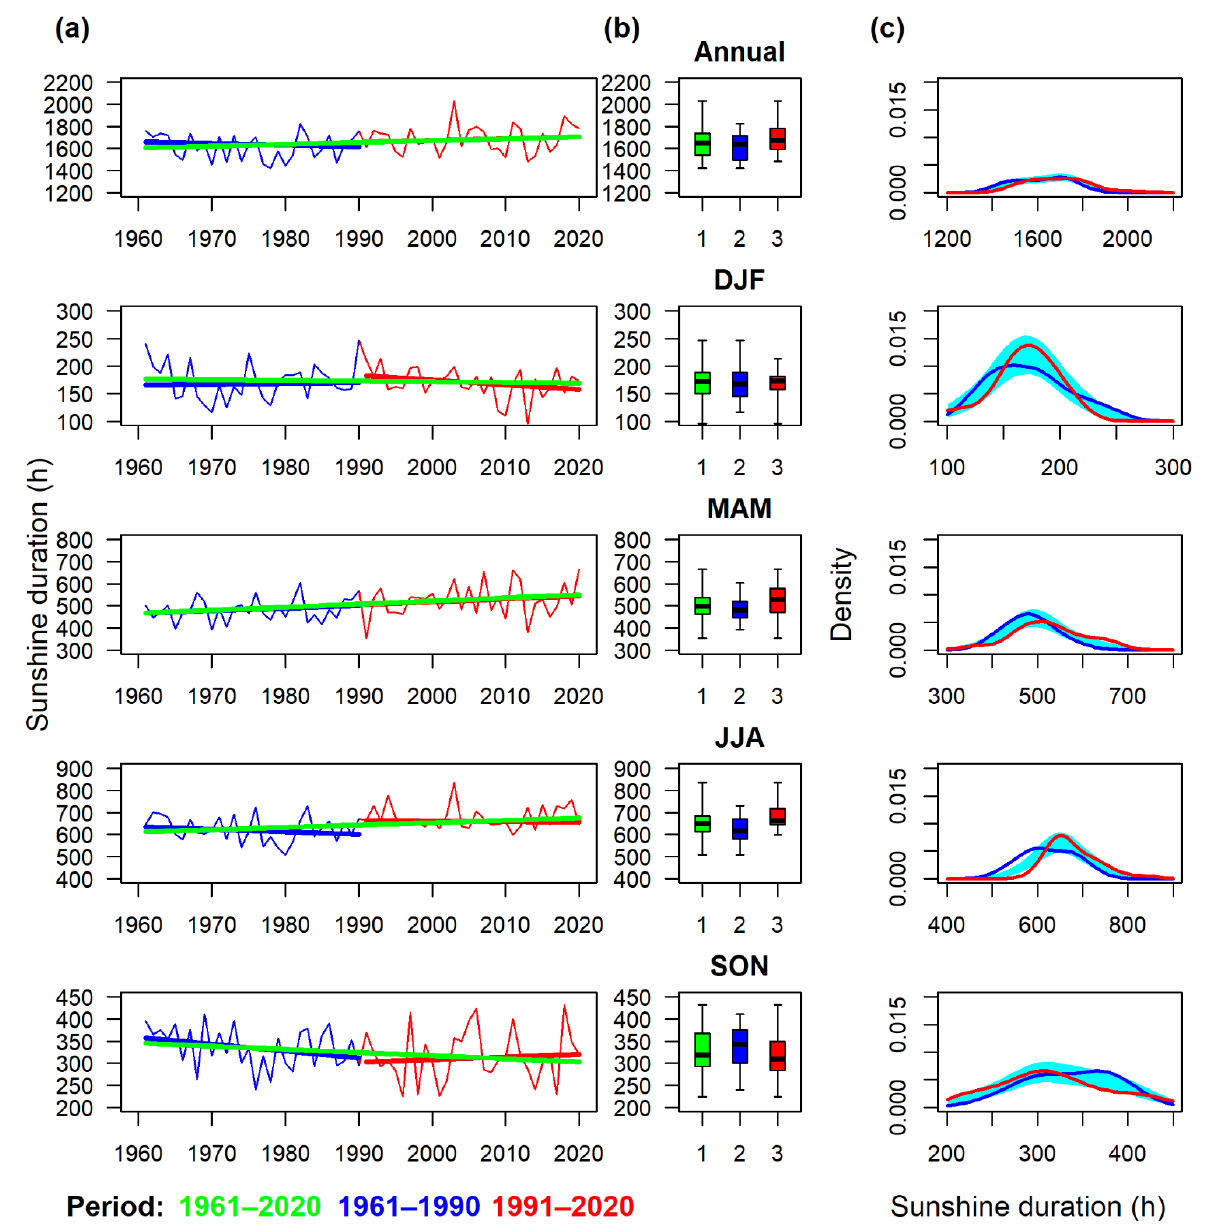
Figure 5. Mean annual and seasonal series of sunshine duration for the territory of the Czech Republic in the 1961–2020 period: ( a ) fluctuations with linear trends in the entire period, 1961–1990 and 1991–2020; ( b ) box plots (median, lower and upper quartile, minimum, and maximum) for 1961–2020 (1), 1961–1990 (2), and 1991–2020 (3); ( c ) the density distribution of the series in 1961–1990 and 1991–2020. The density curves outside the reference band (green–blue) indicate a significant difference in the two distributions (and vice